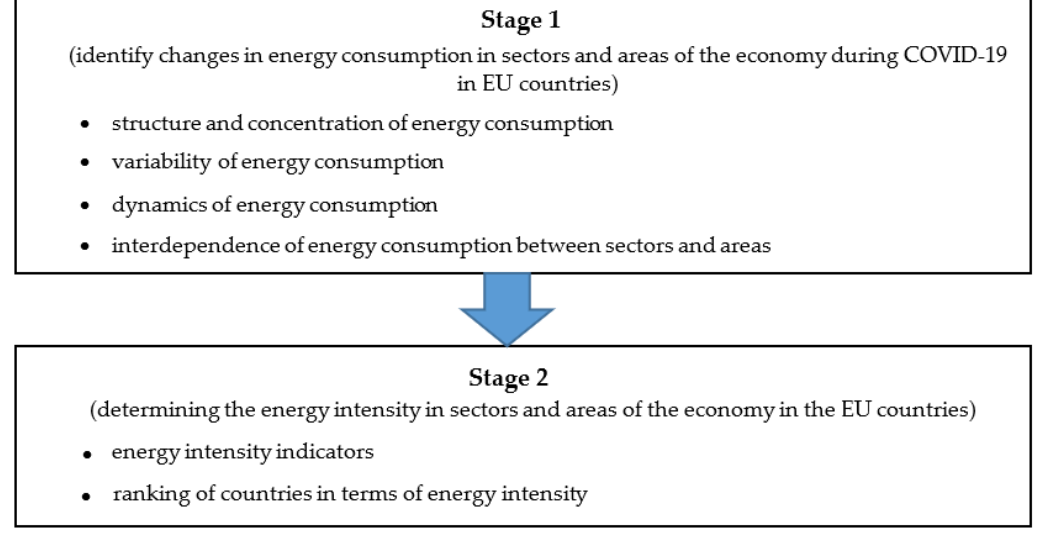
Figure 1. Diagram of the conducted